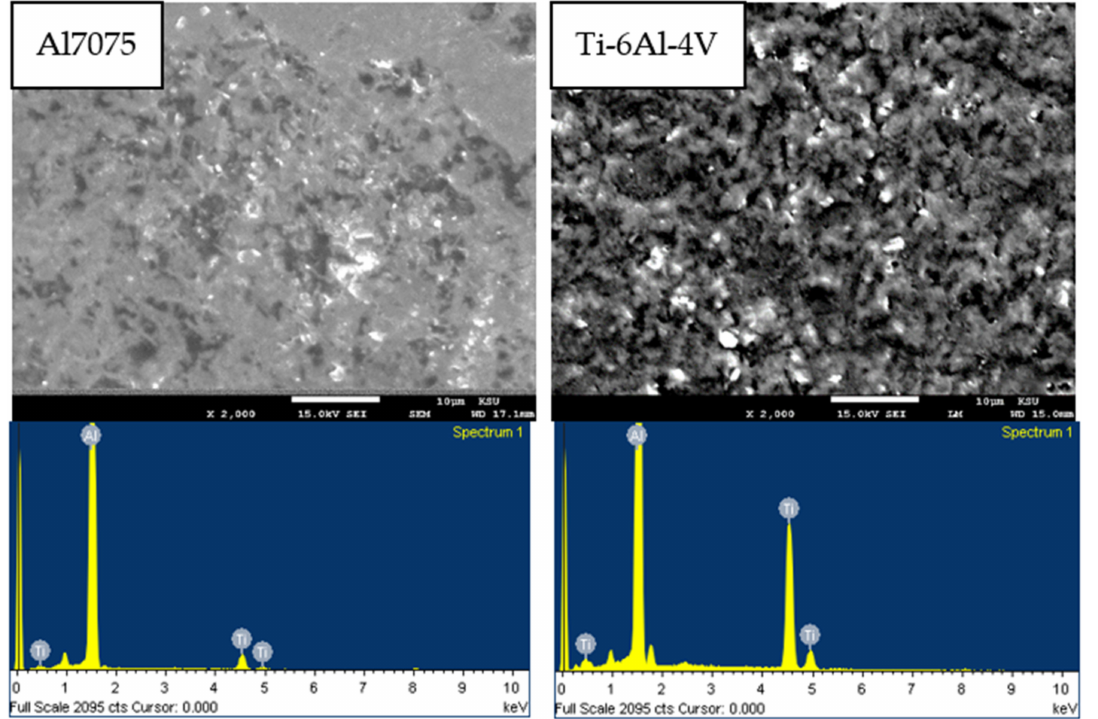
Figure 6. SEM images with the corresponding area scan EDS of the fractured surfaces for bond made at 520 ◦ C holding time.